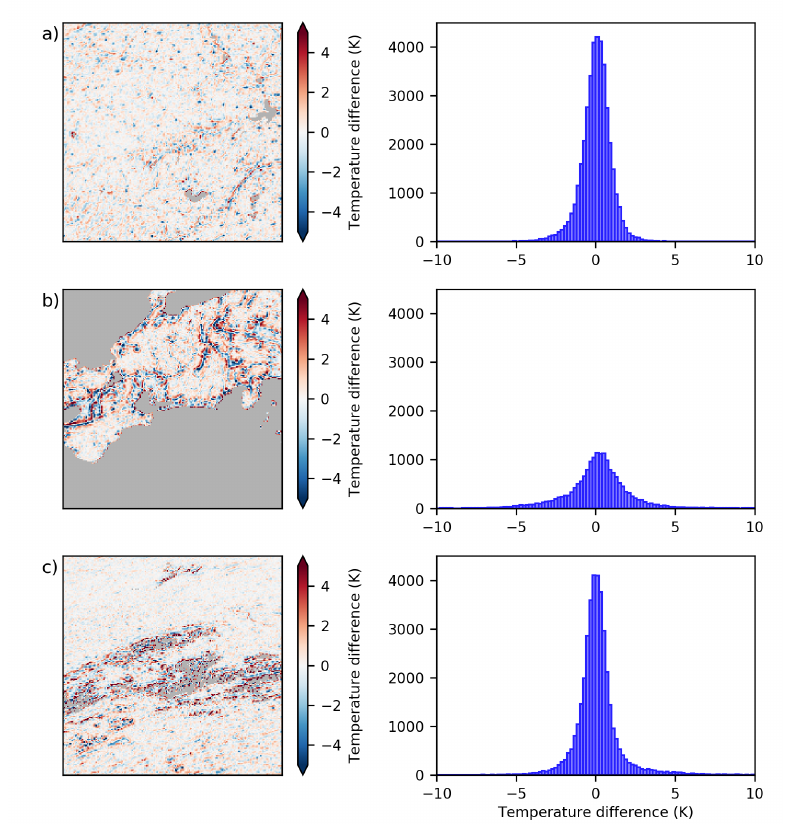
Figure 7. Mean difference between contextual estimates and the central pixel for the selected period for each area. ( a ) eastern China (chn); ( b ) central Honshu (jpn); and ( c ) Siberia